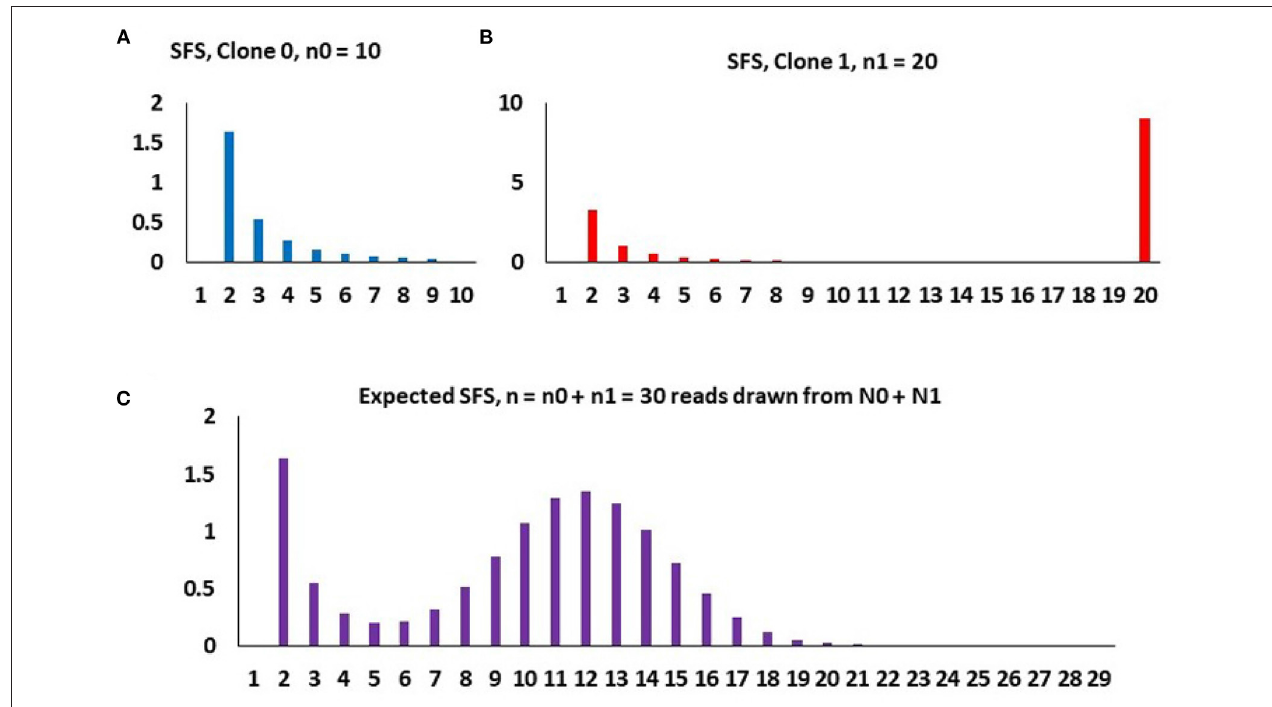
FIGURE 4 | An example of how the composite SFS for two clones ( m = 1) arises under binomial sampling of DNA reads, with parameters , n = 30, K 1 = 8, p 1 = 0.4, and A = 3.4. (A) Purely neutral SFS of Clone 0 based on the sample of n 0 = 10 cells, mathematically q 0 k = p 0 n 0 θ 0 / [ r 0 k ( k − 1)], k = 2, ... , n 0 − 1. (B) SFS of Clone 1 based on the sample of n 1 = 20 cells, with a spike representing all 20 cell having the K 1 = 8 mutations defining Clone 1 and the neutral component, mathematically q